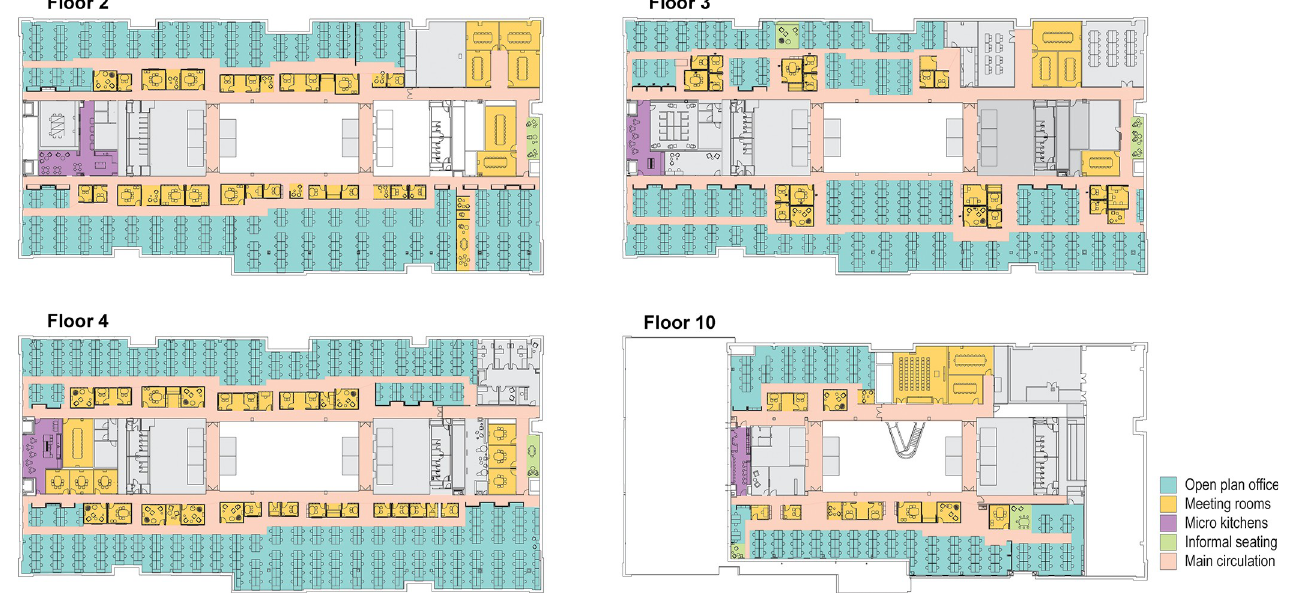
Fig 1. Annotated floor plan of the four floors of office accommodation at ‘Tech’ that were included in the study. https://doi.org/10.1371/journal.pone.0250058.g001 PLOS ONE | https://doi.org/10.1371/journal.pone.0250058 April 28,